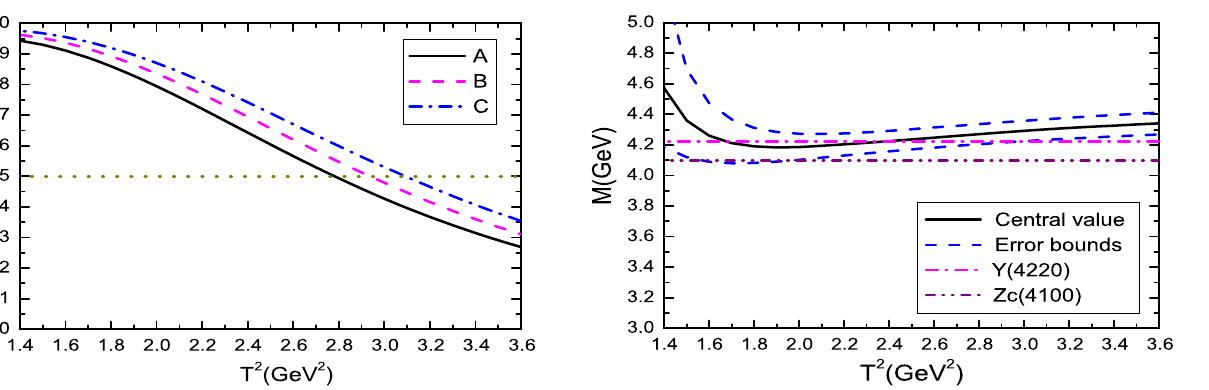
Fig. 3 The mass of the Y ( 4260 / 4220 ) as vector tetraquark state with √ s 0 = 4 . 7GeV, variation of the Borel parameter T 2